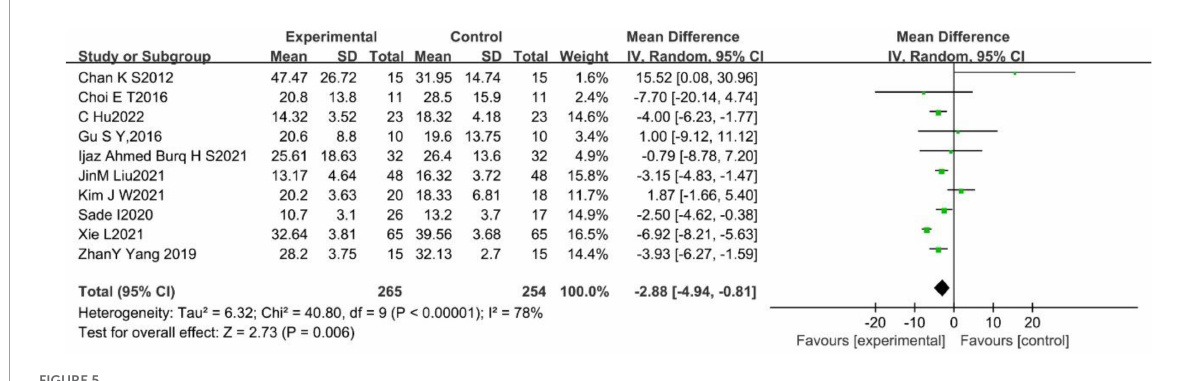
FIGURE5 Forest plot of the effects of WBV training on TUGT.